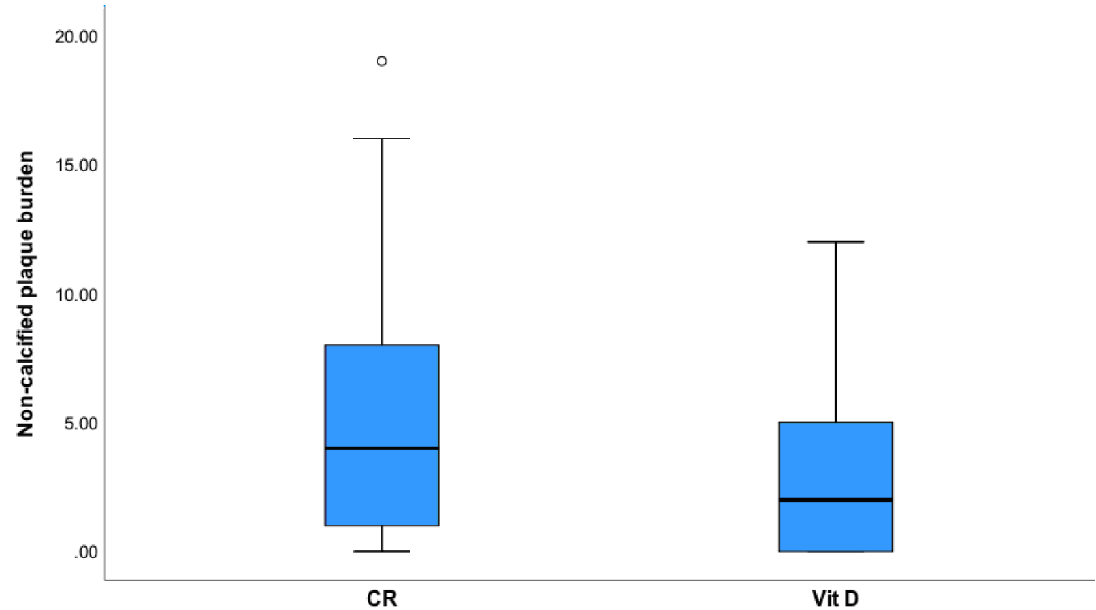
Figure 5. Mixed plaque burden weighted for non-calcified plaque was higher in controls (CR) than in the vitamin D group (Vit D, p = 0.002).